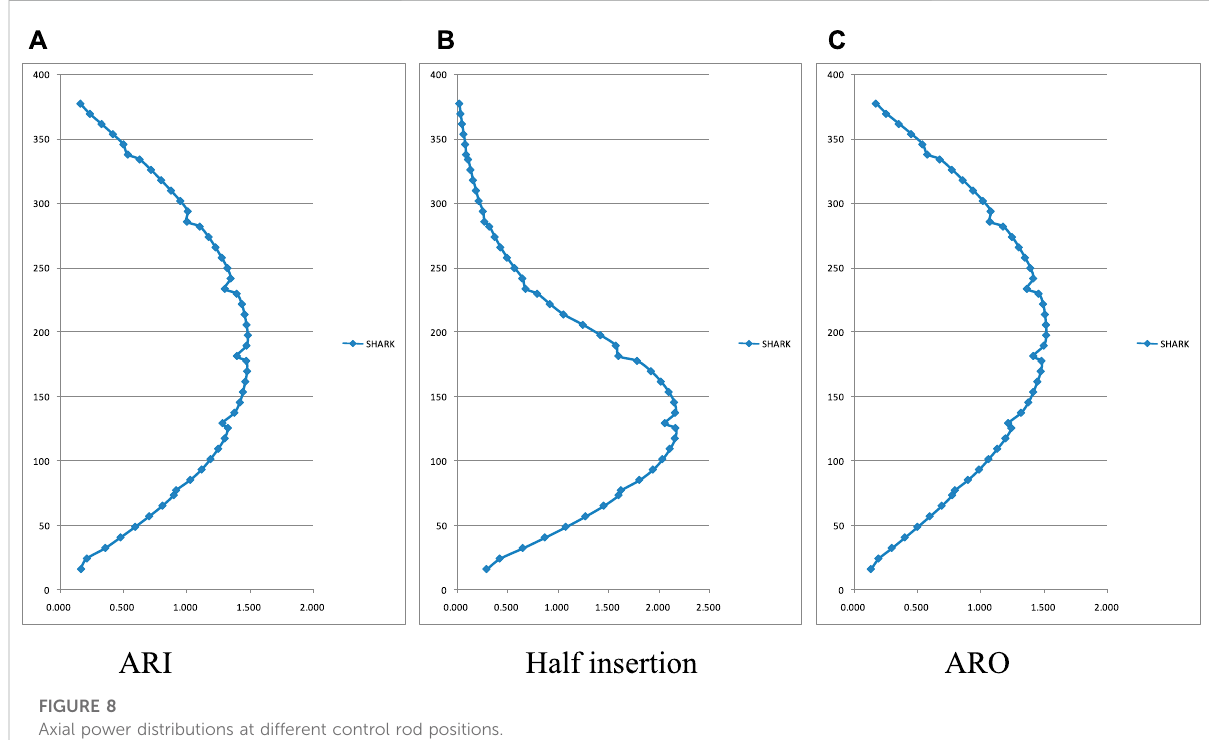
FIGURE 8 Axial power distributions at different control rod positions.